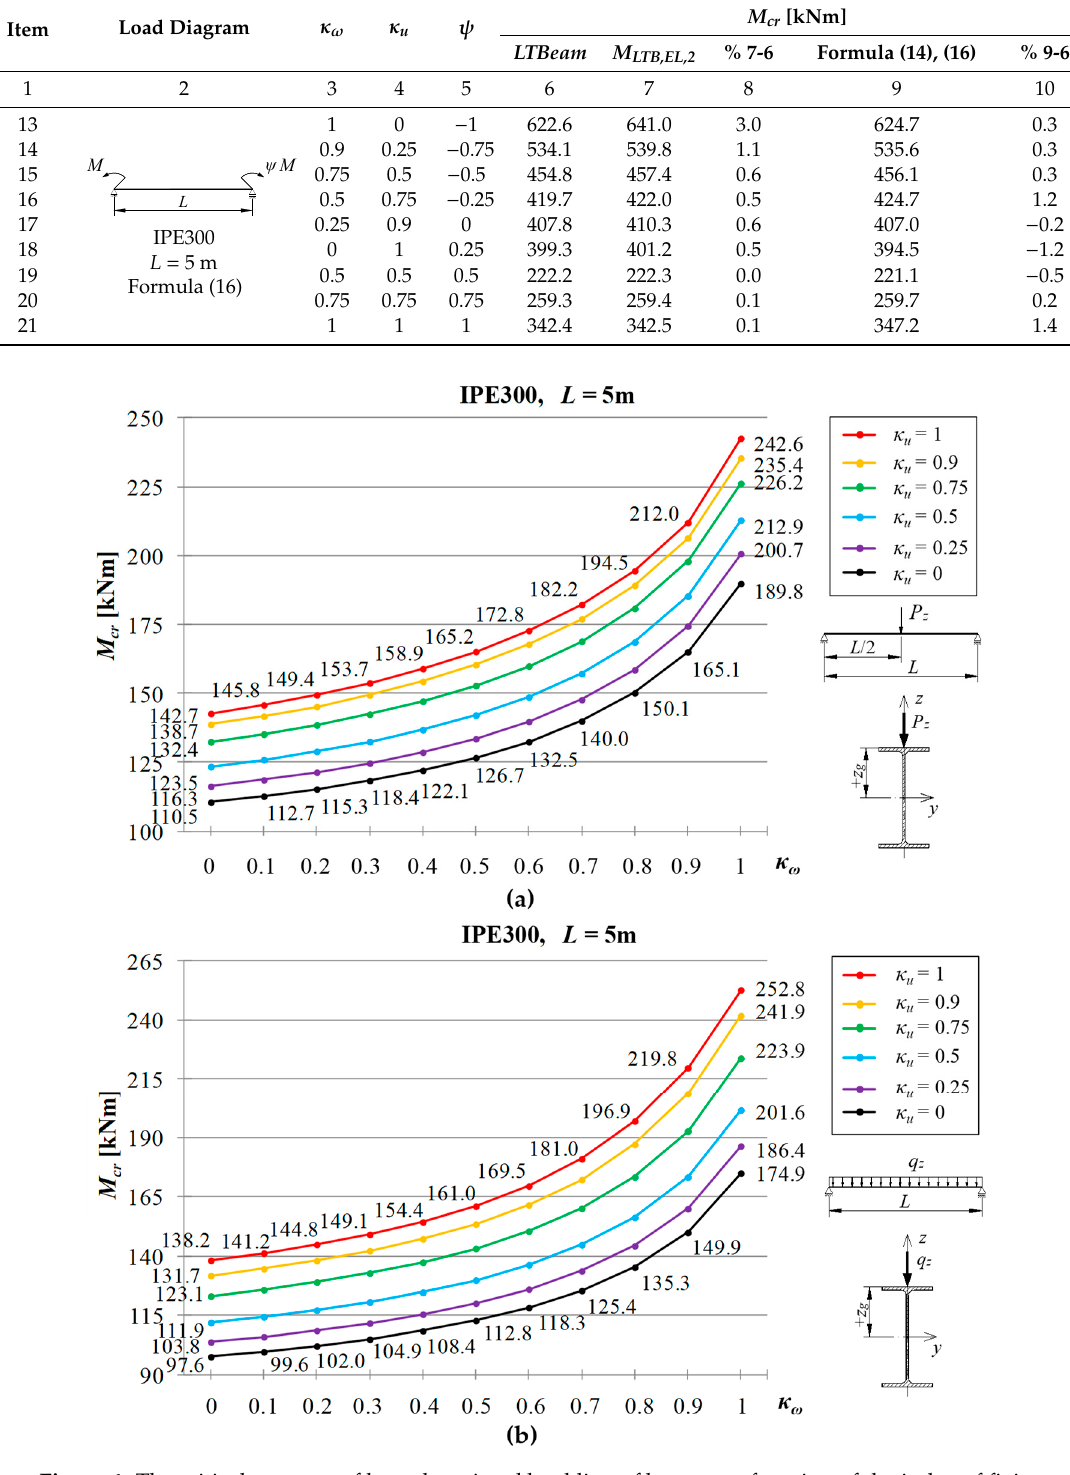
Figure 4. The critical moment of lateral torsional buckling of beam as a function of the index of fixity κ ω , for selected index of fixity κ u : ( a ) beam with concentrated force load, ( b ) beam with uniformly distributed load.